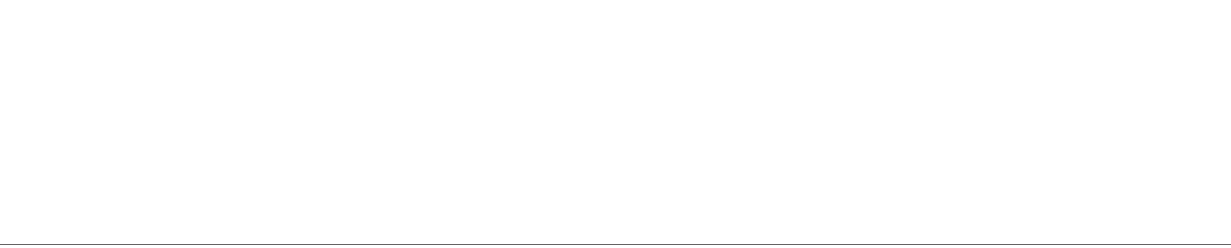
Frontiers in Medicine |